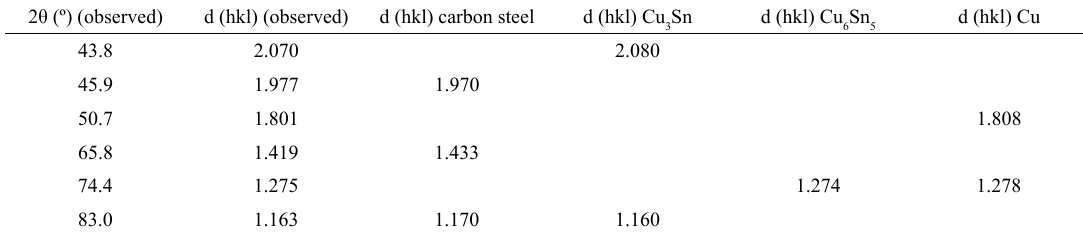
Table 3. Values of d (hkl) for the Cu-Sn coating produced using j = 100 A m -2 .